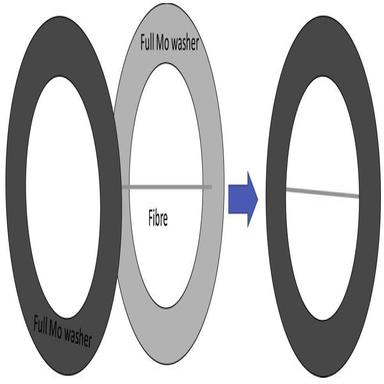
Schematic of the clamping of GO grafted on CF specimen for CFTEM sample holder for taking the images.